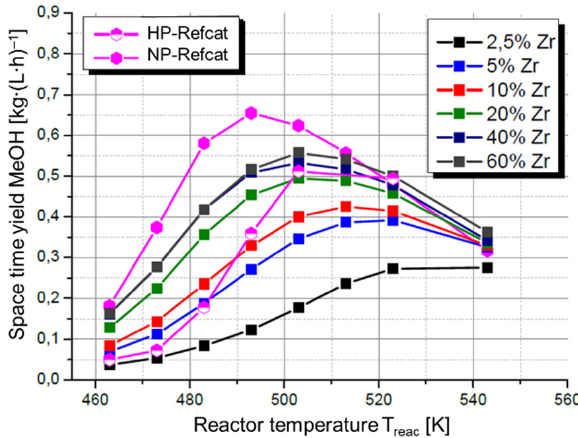
Figure 16. Space time yield MeOH depending on the reactor temperature and the zirconium substi- tuted amount of Al in %. Catalyst system: Cu 0.61 Zn 0.21 Al 0.18-(0.18 ∙ xZr) Zr (0.18 ∙ xZr), h equ = 600, T calc = 873 K, t calc = 2 h. Catalytic tests: p = 5 MPa, GHSV = 2400 h − 1 , S = 2, Feed = 22 vol% H 2 , 62 vol% CO, 6 vol% CO 2 , 10 vol% Ar.